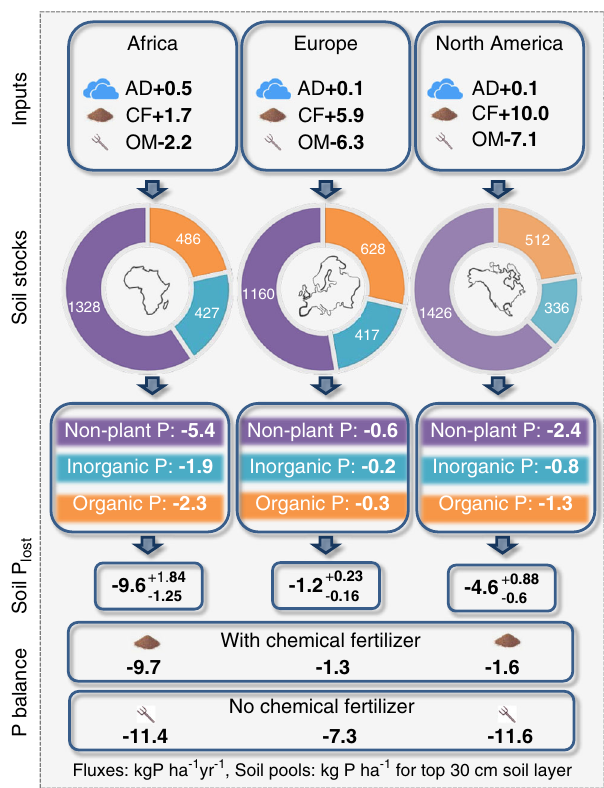
Fig. 4 Soil P pools and depletion due to erosion in Africa, Europe and North America. AD = Atmospheric Deposition. CF = Chemical Fertilizer. OM = Organic P management = sum of manure and residue input minus plant uptake. Arrows indicate fl uxes (positive: net input to soils, negative: depletion of soils). Non-plant P = non-plant available P. Inorganic and organic P give plant available fractions. Soil P lost : sum of P fractions lost from soil via erosion with relative errors. No/with chemical = P balance with and without chemical